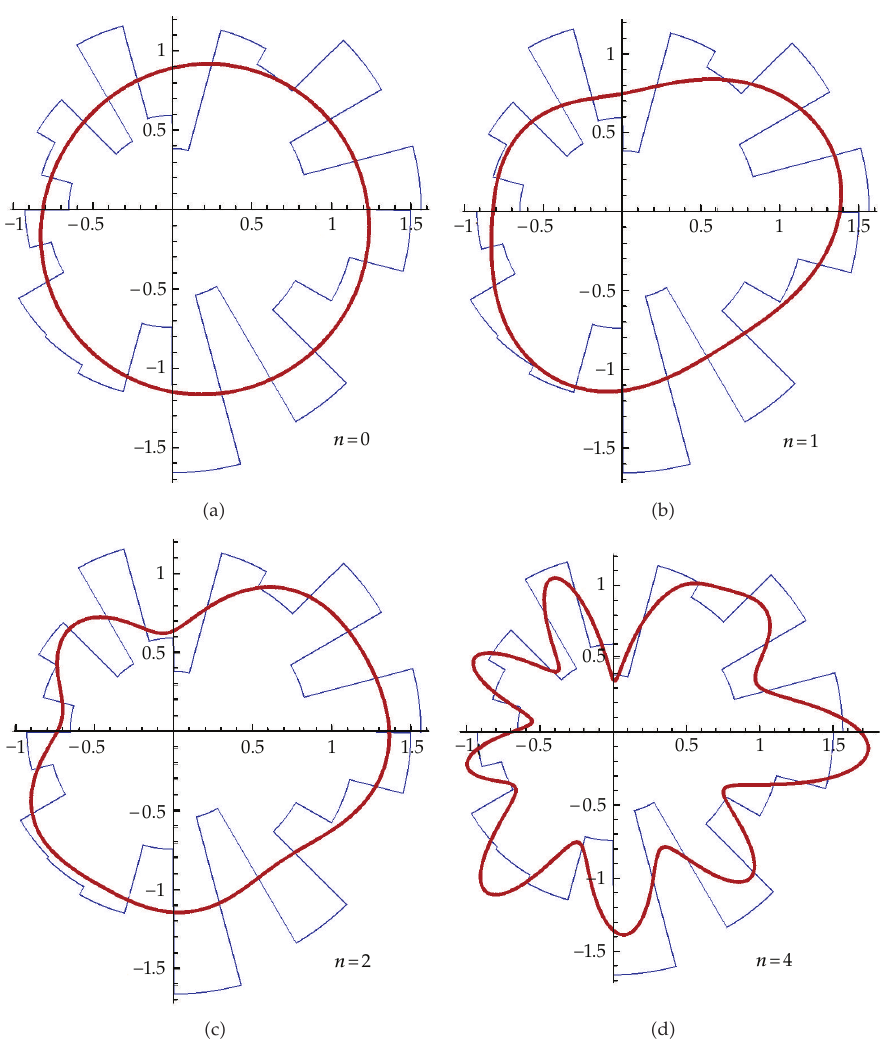
Figure 3: Original scalar-valued ODF sampling from N (cid:3) 1 . 0 , 0 . 3 2 (cid:4) and its approximate ODFs using asym- metric characterization in